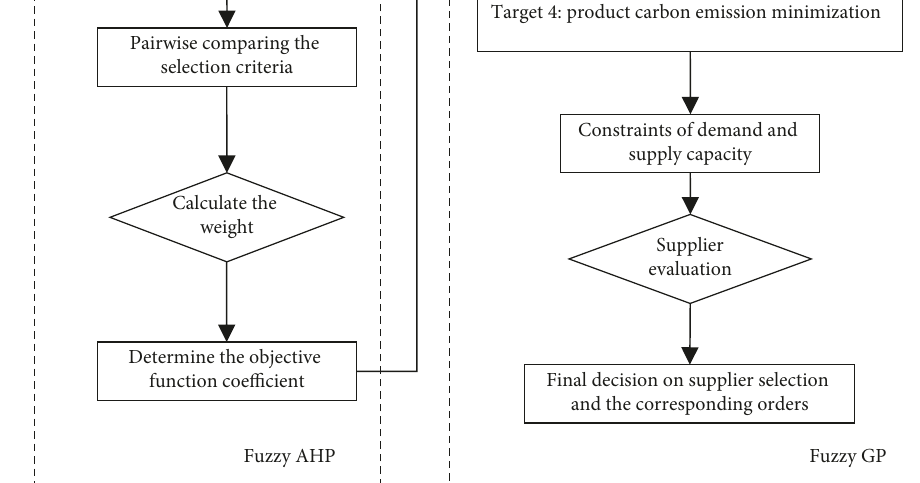
Figure 1: The AHP-GP procedure.